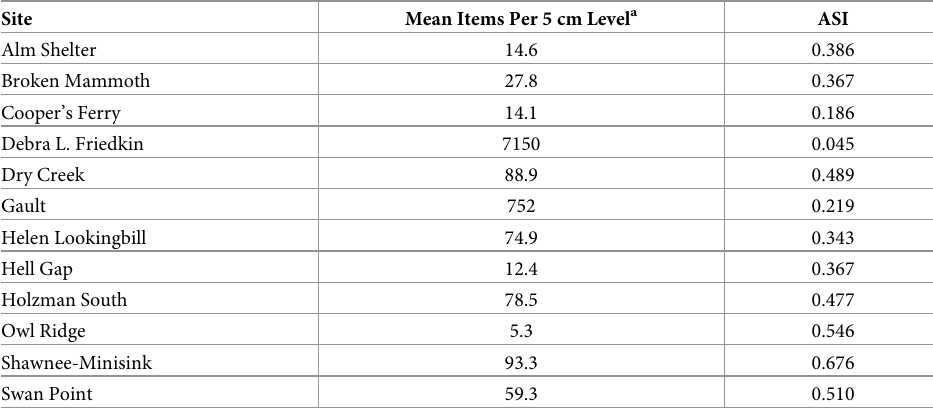
a Mean counts are calculated after removal of consecutive sterile levels.